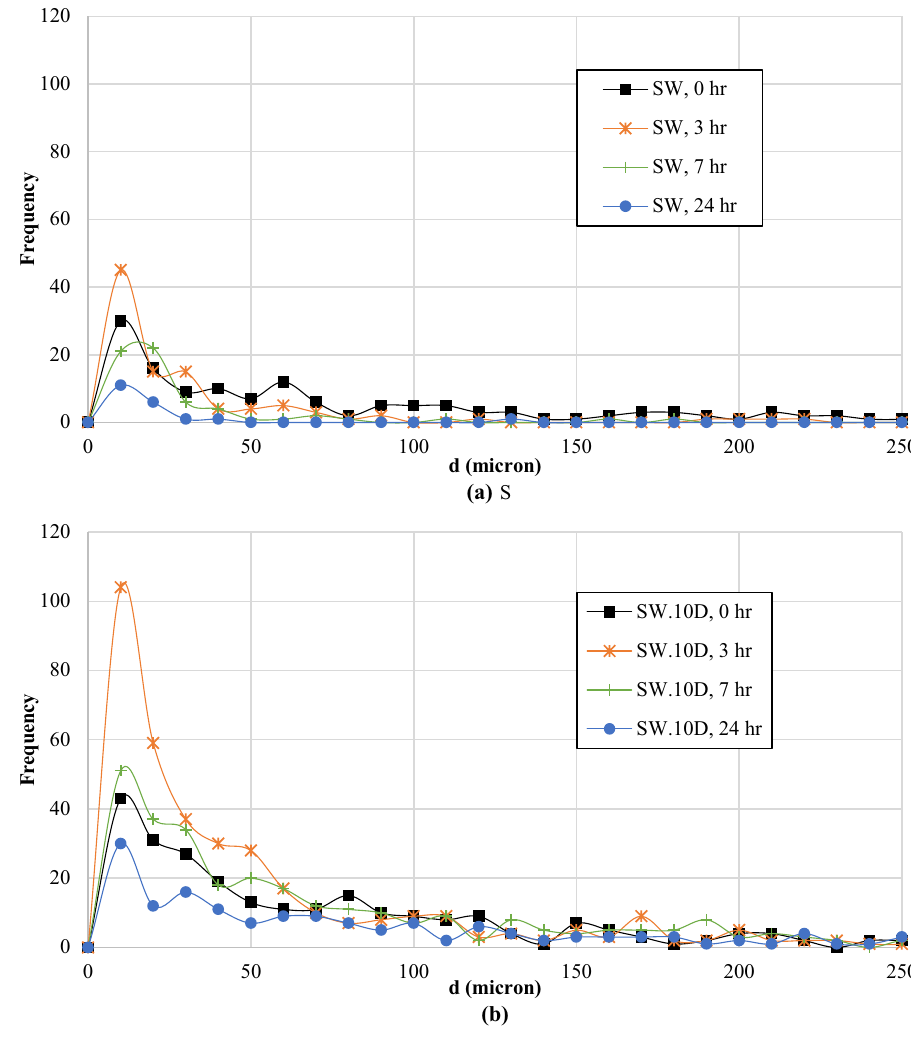
Fig. 6 Emulsion stability analy- sis for different brines at differ- ent times. a SW, b